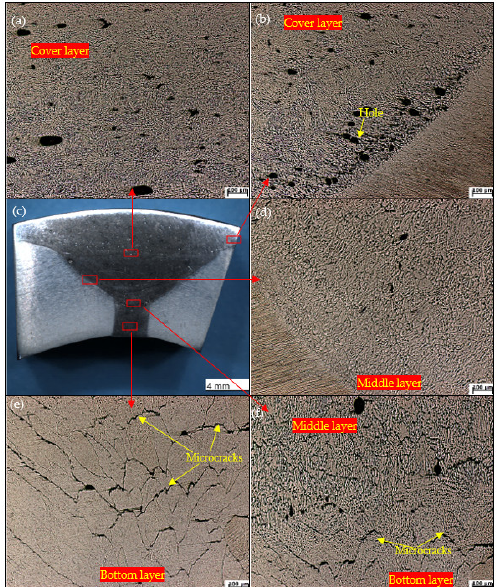
Figure 10. Face bending specimen metallography of the ER5356 welded joint, ( a ) the interface between the cover and middle layers, ( b ) the FZ of the cover layer, ( c ) the macromorphology of cross-section of the weld joint, ( d ) the FZ of the middle layer, ( e ) the weld center of the bottom layer, and ( f ) the interface between the middle and bottom